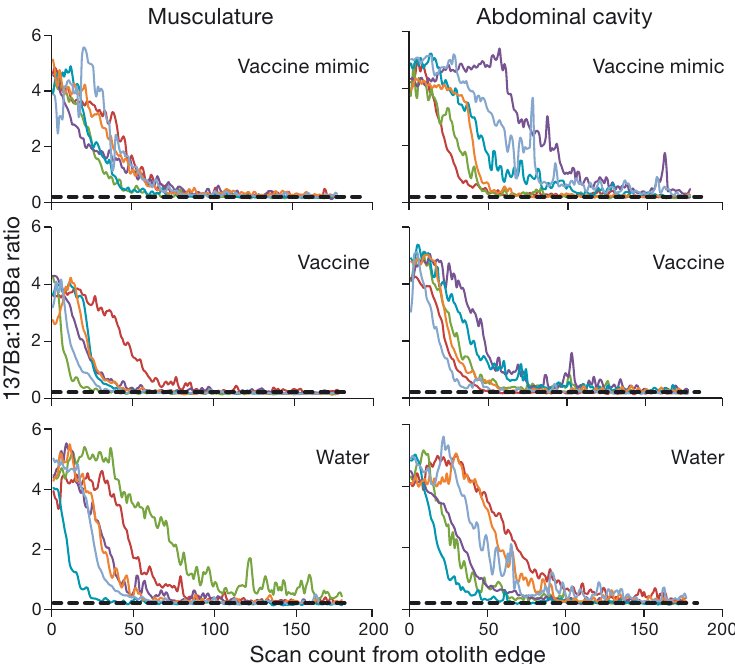
Fig. 1. Salmo salar. Mark success with 137 Ba: 138 Ba for the 6 enrichment treat- ments. Treatments differed in the isotopic carrier solution used (vaccine mimic, vaccine, water) and the injection location (musculature or abdomi- nal cavity). Coloured lines represent individual Atlantic salmon. Black dashed line represents average control ratio + 3.3 SDs. A scan is defined